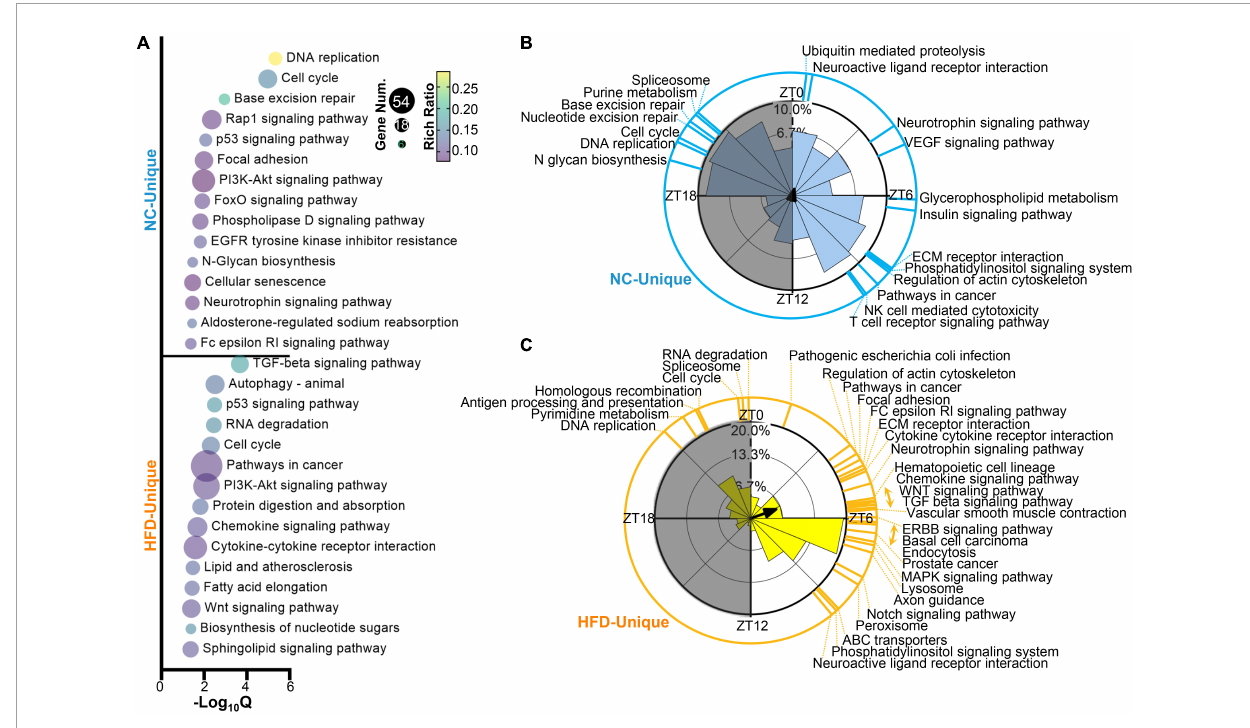
FIGURE3 High-fat diet (HFD) alters the oscillatory characteristics of circadian transcriptomic profiling in murine MGs. (A) Functional annotations for NC-unique (up) and HFD-unique (down) cycling genes by GO Biological Process analysis ( Q < 0.05). Phase distribution of significantly enriched KEGG pathways ( Q < 0.05) in the MGs of NC-fed (B) and HFD-fed (C) mice. The blue (B) and yellow (C) lines on the outside circle indicate the enriched pathways at various phases. Gray shading: dark phase.